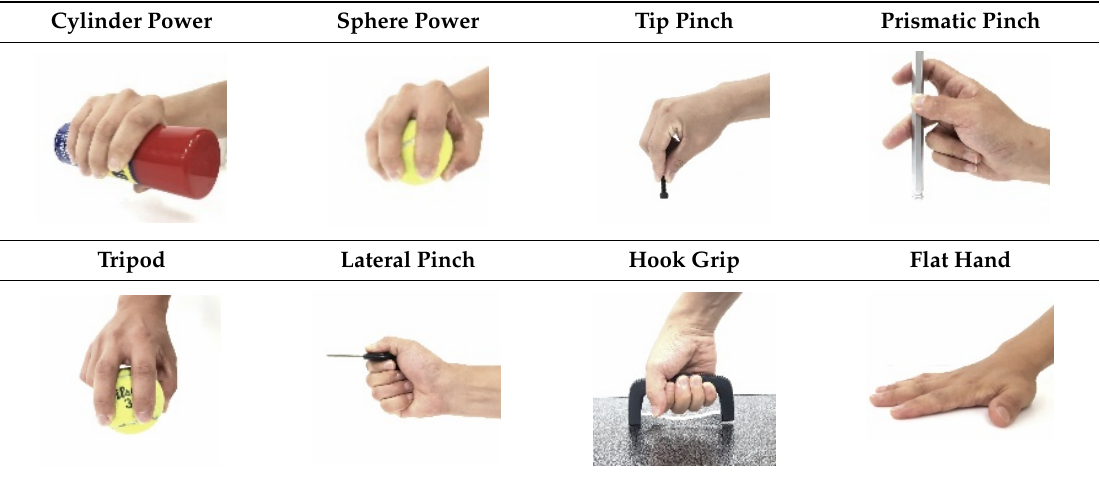
Table 1. Eight grasping motions of an underactuated hand.